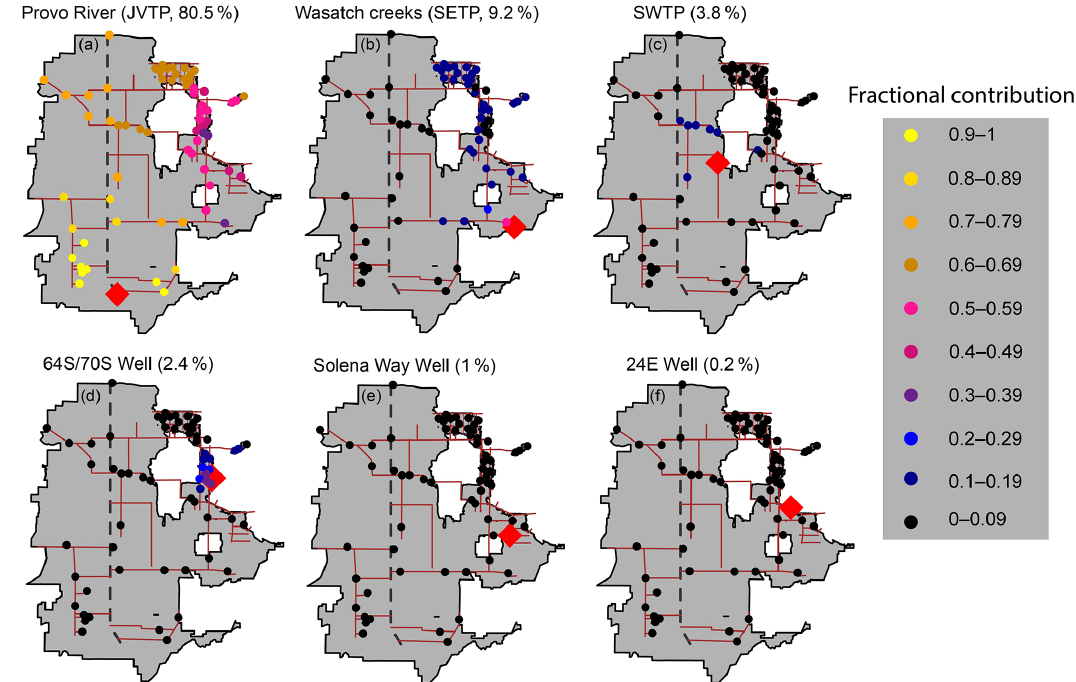
Figure 2. Mean prior contribution of selected sources at the distribution sites for June 2015 based upon Eq. (6) described in Sect. 2.4. Distribution sites are shown as circles, and the color reflects the assigned prior contribution from the different sources. The source location is shown as a red diamond in each panel. The name of each source and its percent volumetric contribution ( V ) is shown above each panel.